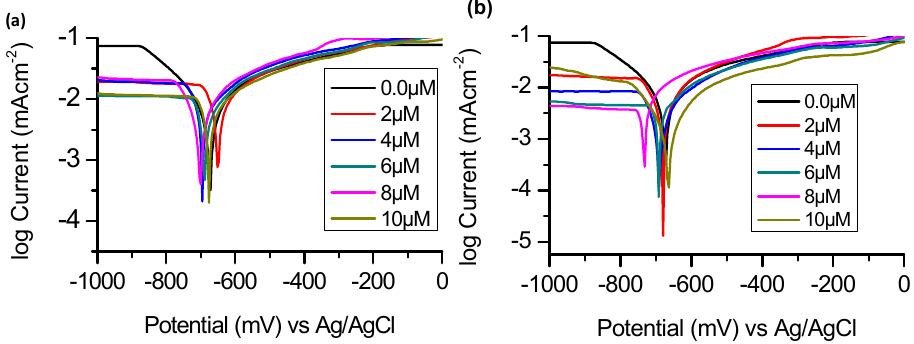
Figure 3. Potentiodynamic polarization curves for aluminum in 1.0 M hydrochloric acid in the absence and presence of ( a ) BTThio and ( b ) ClGaBTThioPc at 28 °C.